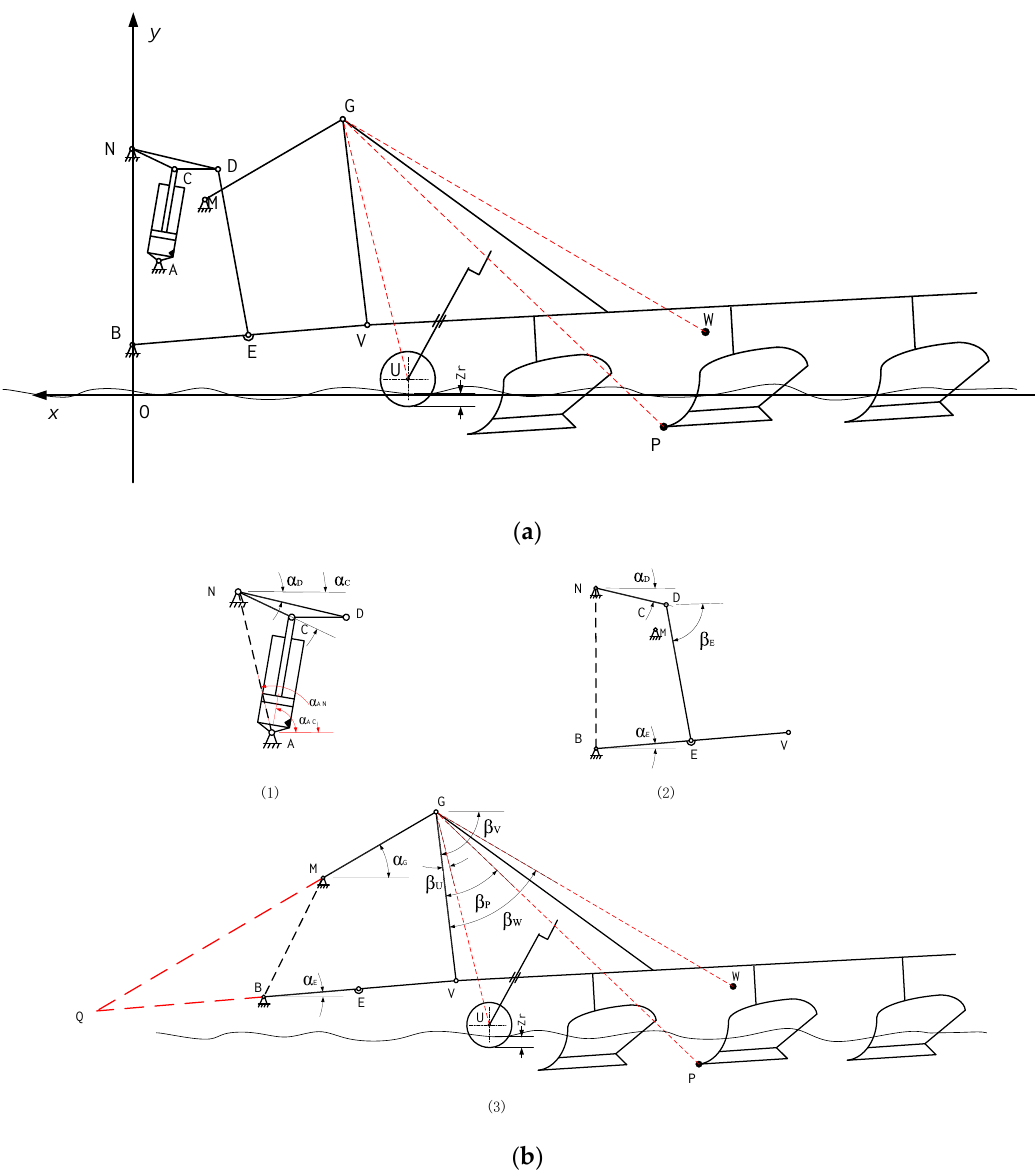
Figure 1. The structure of the tractor electronic hydraulic hitch: ( a ) whole part; ( b ) magnified part. The vertical line passing through point B as the horizon is recorded as the y-axis, positive upward; the horizon is recorded as the x-axis, positive left; the intersection point O is recorded as the coordinate origin.